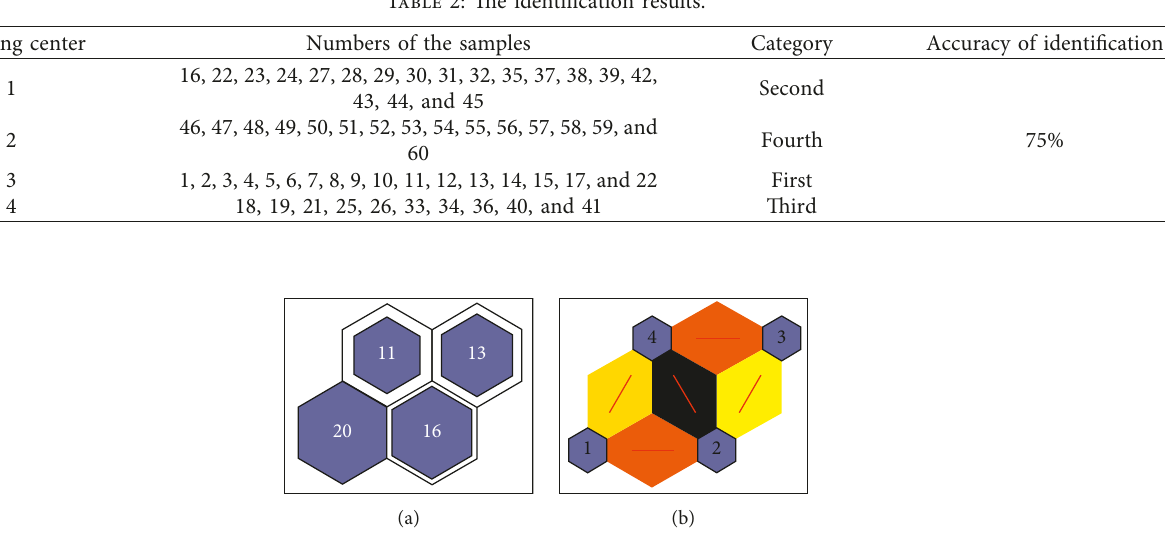
Figure 6: (a) Visualized clustering results and (b) weight distances between adjacent neurons of the water-adulterated salmon identification model based on texture features and feature spectra.